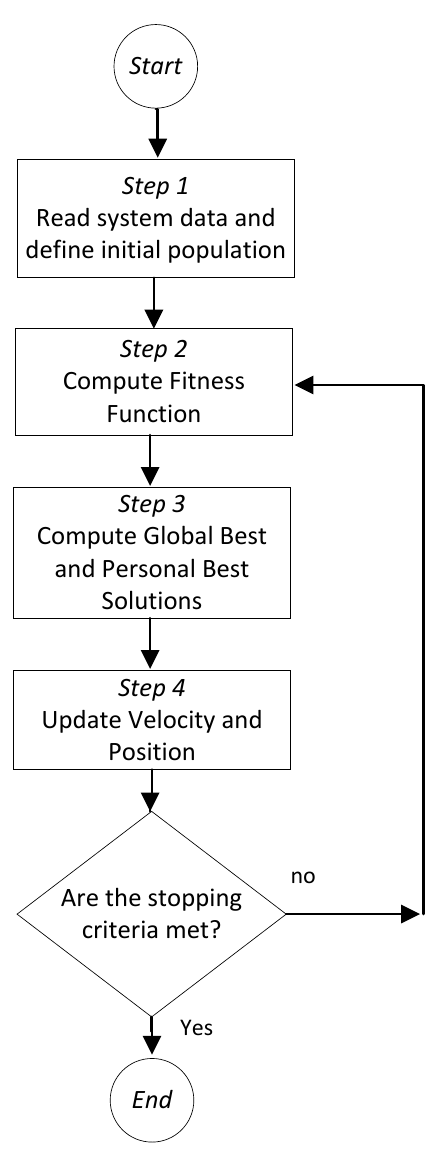
Figure 1. Flowchart of the implemented PSO